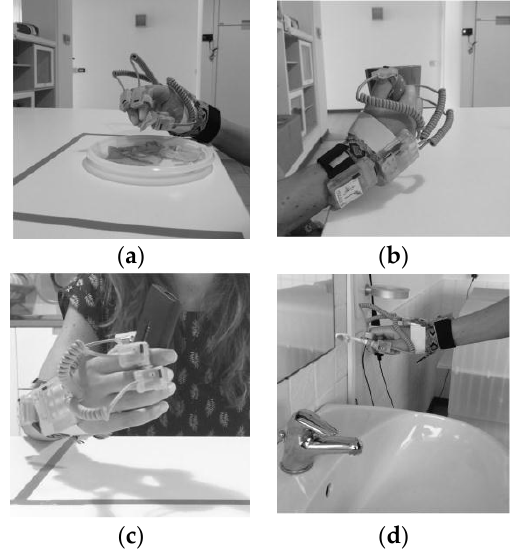
Figure 2. Focus on grasping of objects involved in the different gestures ( a ) grasp some chips with the hand (HA); ( b ) take the cup (CP); ( c ) grasp the phone (PH); ( d ) take the toothbrush (TB).